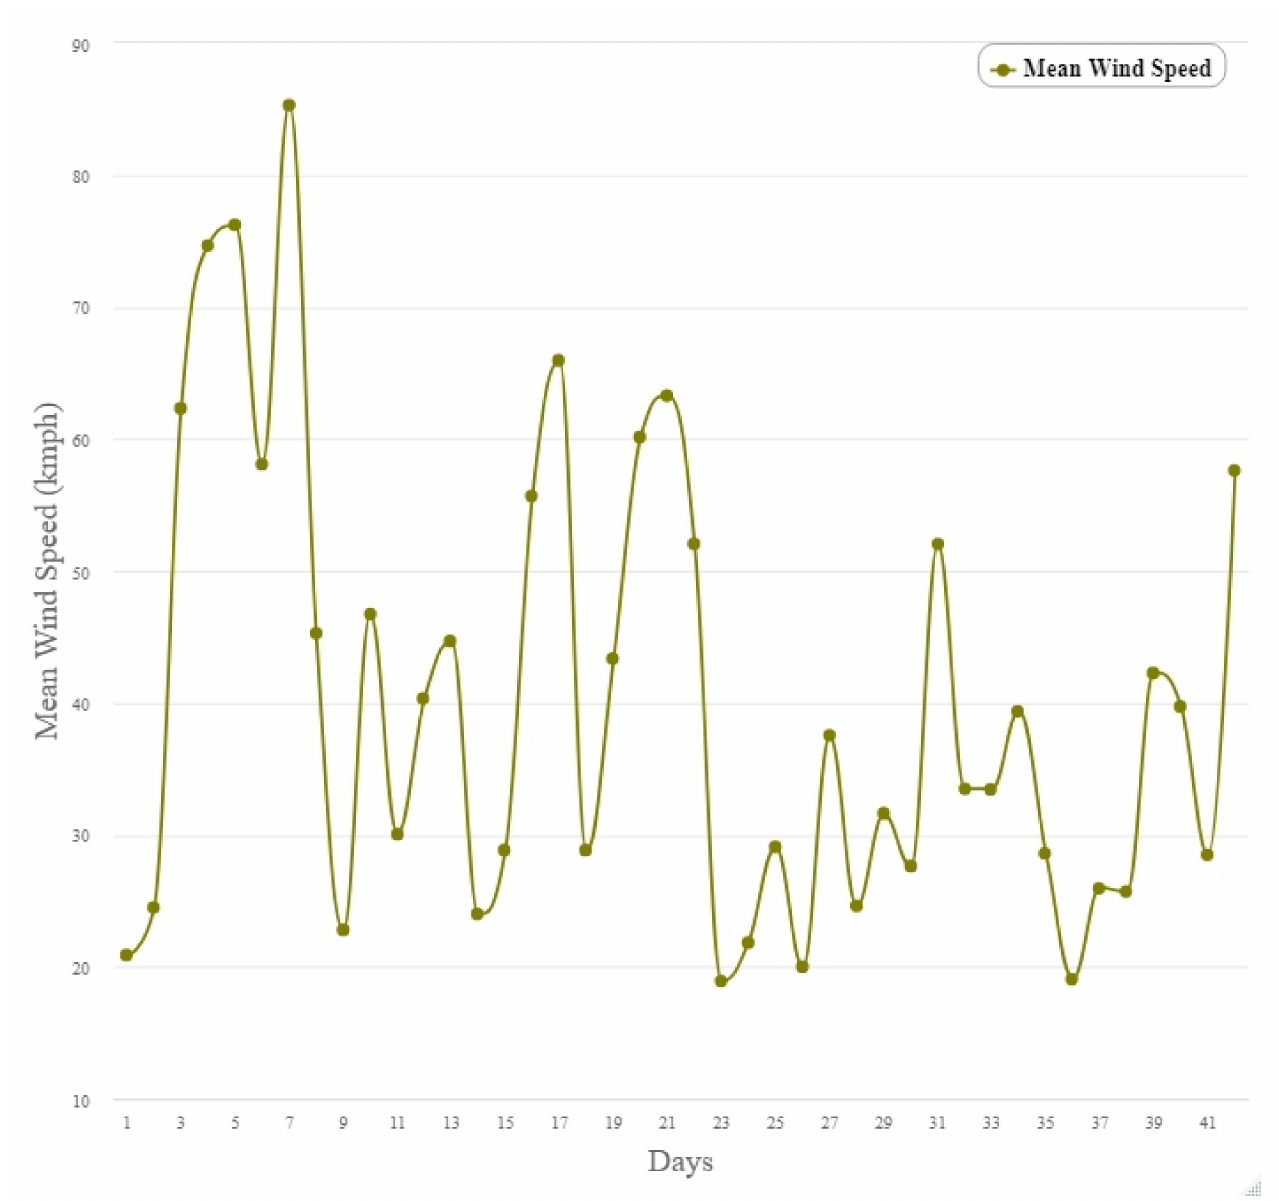
Figure 8. The mean wind speed per day over 42 days (18 January–1 March 2019) from Palmerston North Airport (40 ◦ 19 (cid:48) 15.6 (cid:48)(cid:48) S latitude, 175 ◦ 37 (cid:48) 05.7 (cid:48)(cid:48) E longitude) managed by the National Meteorological Service (https://cliflo.niwa.co.nz/, accessed on 1 October 2019) approximately 8 km from the study